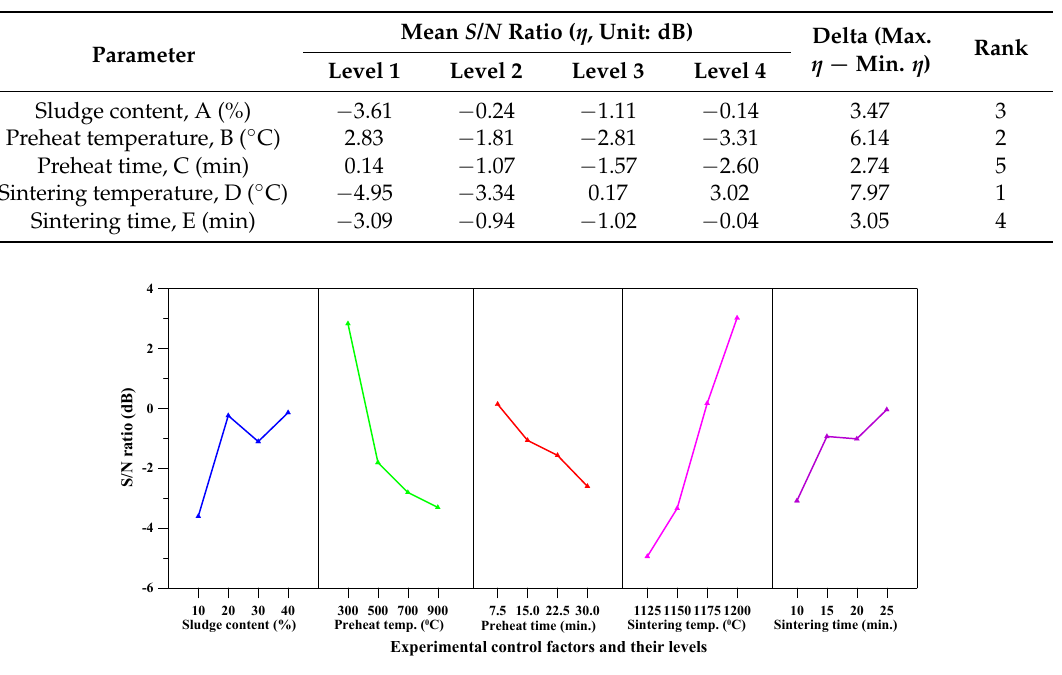
Figure 3. S / N response graph for particle density. Table 6. S / N response table for particle density.